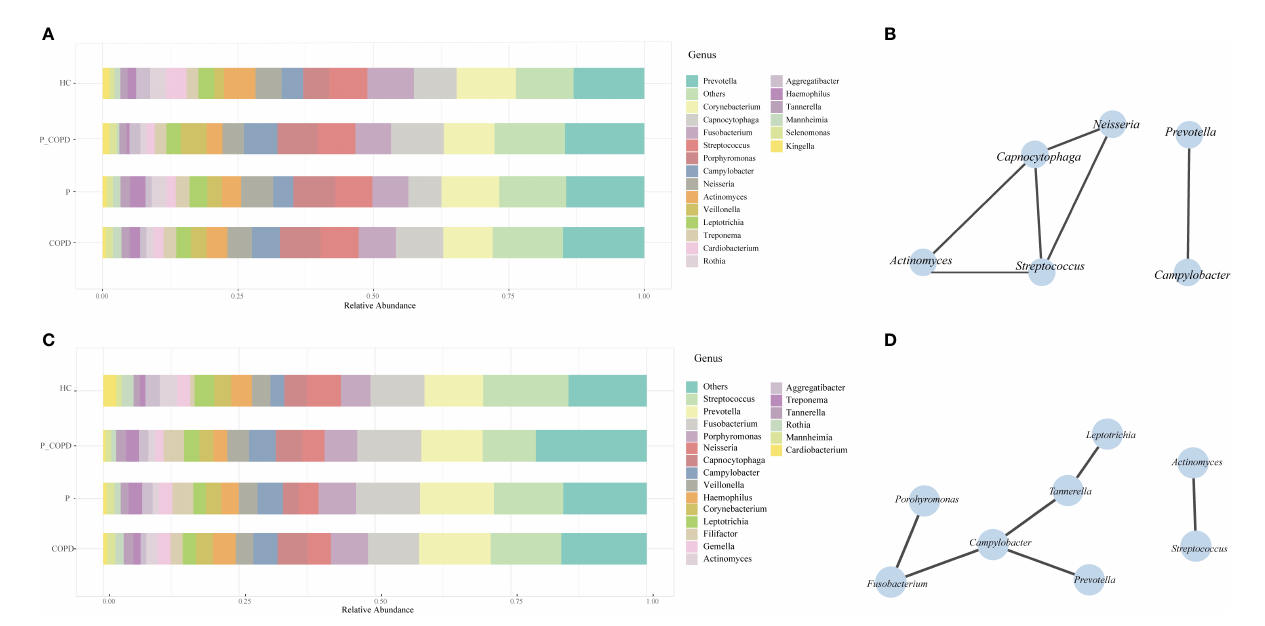
FIGURE 2 Relative abundances of the oral microbiota in healthy controls (HC), periodontitis (P) group, chronic obstructive pulmonary disease (COPD) group and comorbid diseases (P_COPD) group. Stacked bar plots showing relative abundances of the oral microbiota at the genus level (A) in subgingival plaque samples, (C) in gingival crevicular fl uid samples. The correlation network analysis of the core microbiota based on SparCC. The core microbiota was de fi ned as which covering 100% of all samples. (B) In subgingival plaque samples. (D) In gingival crevicular fl uid samples.